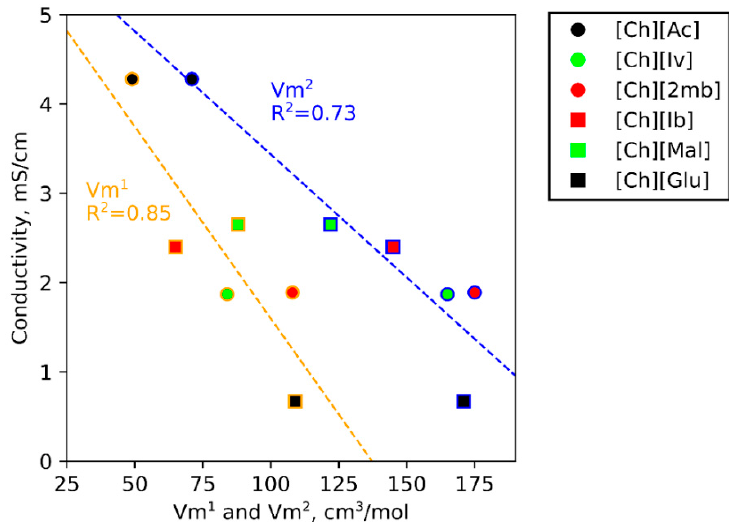
Figure 4. The correlation between the ionic conductivity of ILs after 3 weeks in ambient conditions [15] and the anion size calculated with two different methods.